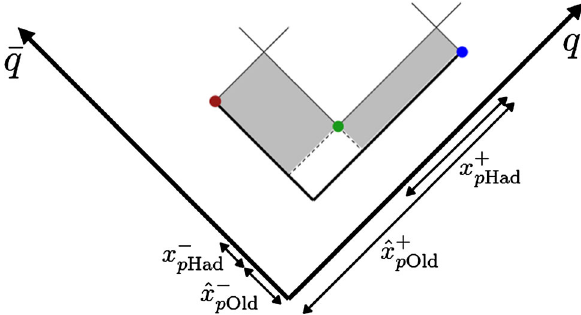
Fig. 30 Final breakup point and final two hadrons, corresponding to thegreyregions,inaq ¯ q system.Theredandbluepointsaretheprevious breakups and the endpoints of the final region, while the green dots represents the final breakup